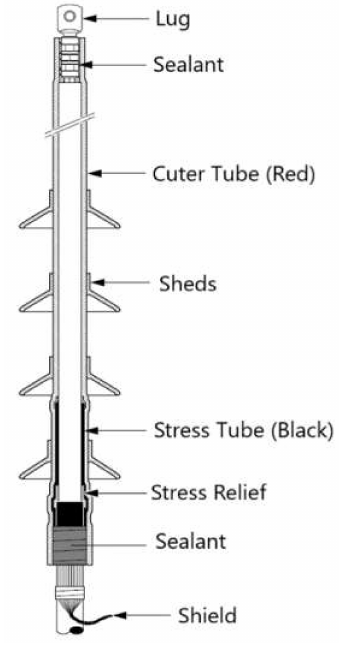
Figure 1. Parts of cable termination